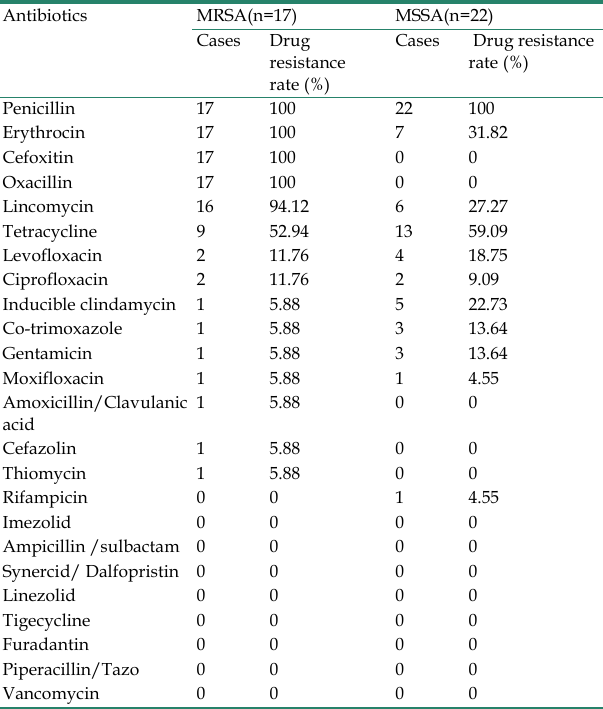
Table 6. The rate of drug resistance of Staphylococcus aureus Antibiotics